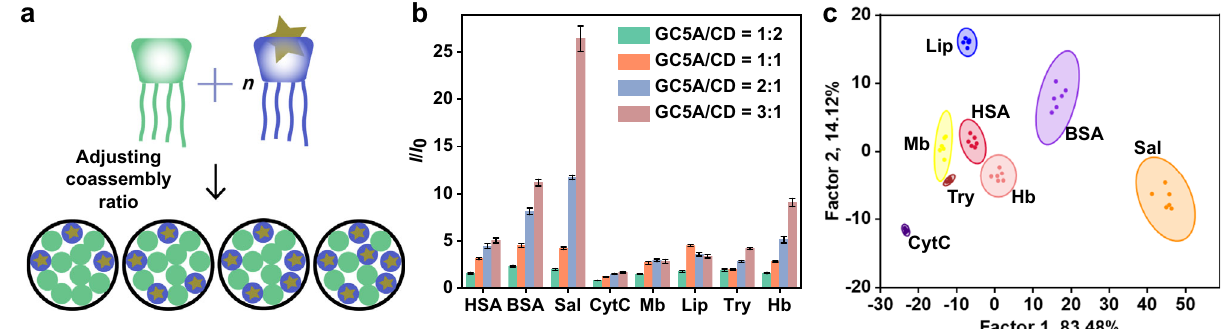
Fig. 5 Construction and experimental results of sensor array based on adjusting coassembly ratio. a Schematic diagram of SA5 . Pattern recognition of proteins using SA5 ([GC5A]/[CD] = 0.5/1.0 μ M, 1.0/1.0 μ M, 2.0/1.0 μ M, and 3.0/1.0 μ M, [AlPcS 4 ] = [GC5A]). b Fluorescence response patterns of SA5 against various proteins (23.8 μ g/mL for each protein). The order of colored symbols from top to bottom in the legend corresponds to the column order of histogram from left to right. c Canonical score plot for the two factors of simpli fi ed fl uorescence response patterns obtained from LDA with 95% con fi dence ellipses. Error bars in b represent mean ± s.d. ( n = 6 independent experiments).